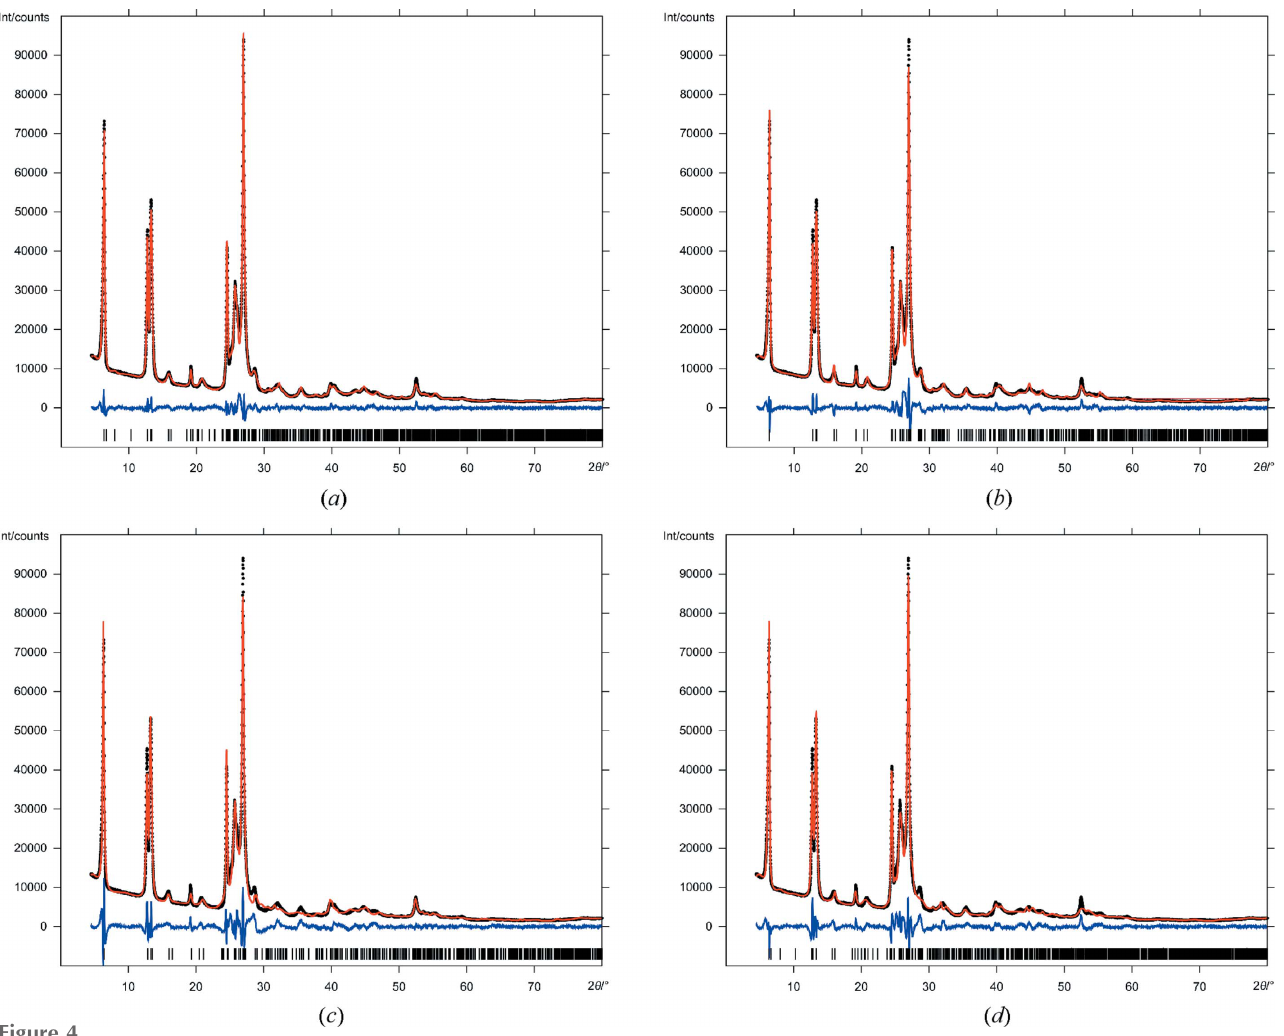
Figure 4 Rietveld plots of structural models A–D. Observed intensities are denoted as black dots, calculated intensities as a red line, difference curve below in blue, vertical ticks represent the reflection